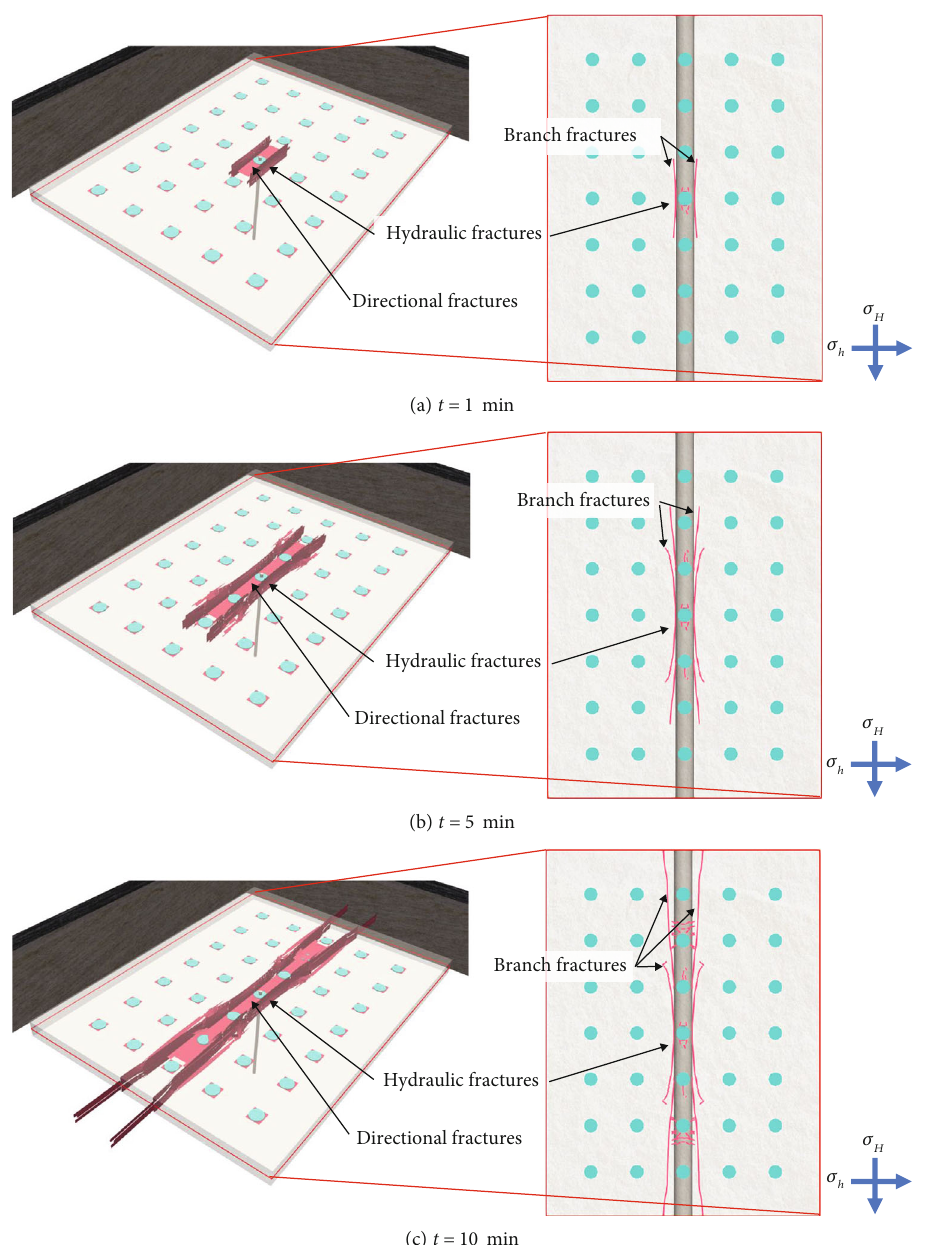
Figure 13: Temporal development of the hydraulic fracture pattern created by hydraulic fracturing in combination with a regular distribution of hydraulic